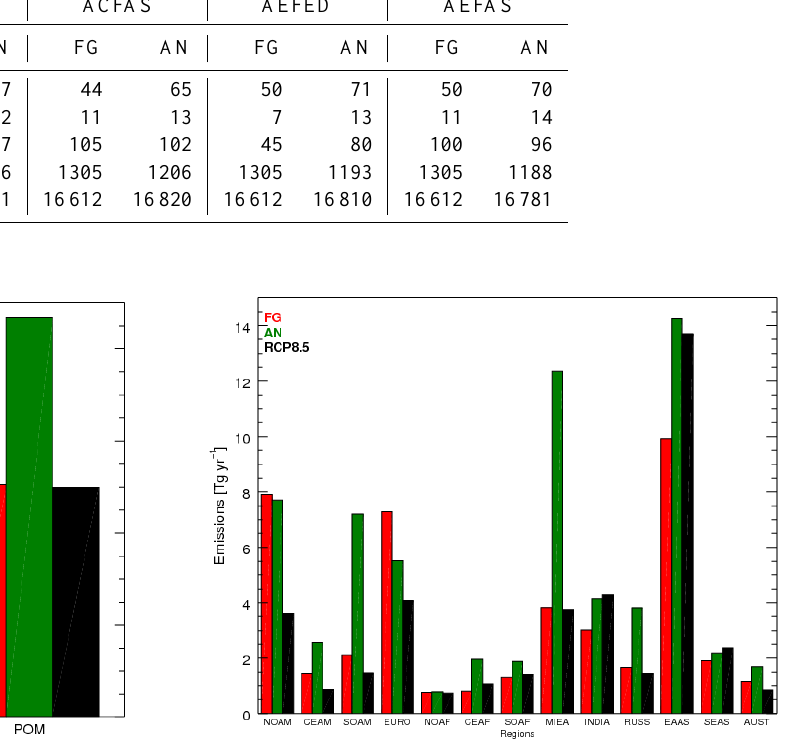
Fig. 3. Global-yearly emissions of SO 2 (in TgSyr − 1 ), BC and POM (in Tgyr − 1 ) of first guess (FG, red), analysis (AN, green) and projected RCP8.5 emissions for the year 2010 (RCP, black). The FG combines the anthropogenic emissions from L10 and the GFED biomass burning emissions.